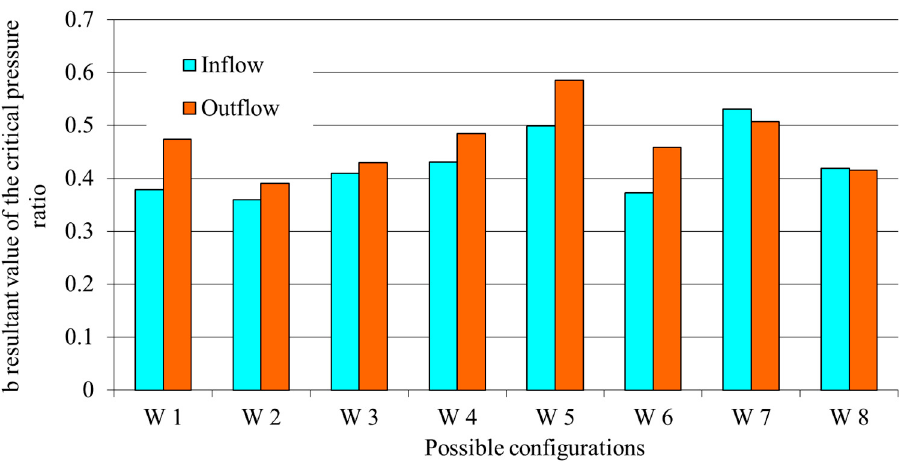
Figure 14. The value of the critical pressure ratio b as a function of the trigger system variant.